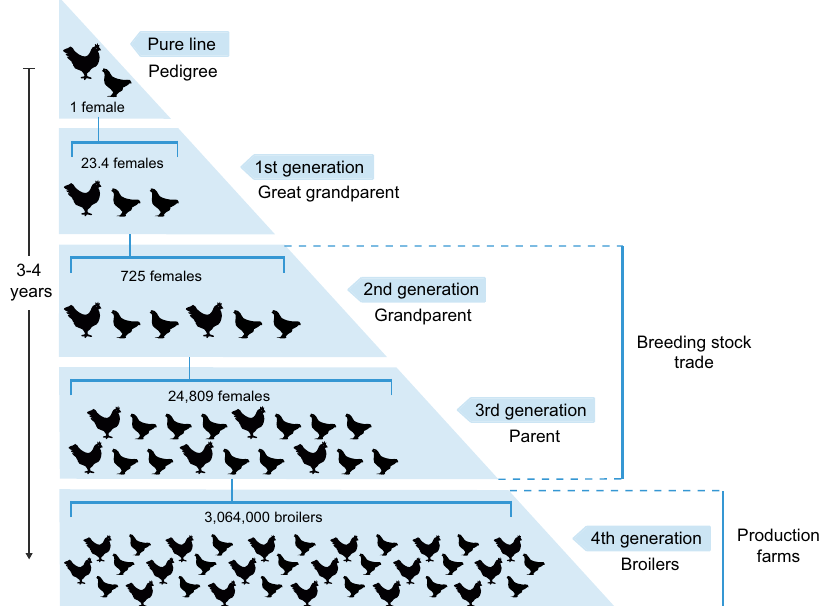
Fig. 1 Breeding pyramid of industrialized poultry production. Poultry fl ock sizes derived from a single pedigree female chicken was according to the estimate by Van Eenennaam et al. 4